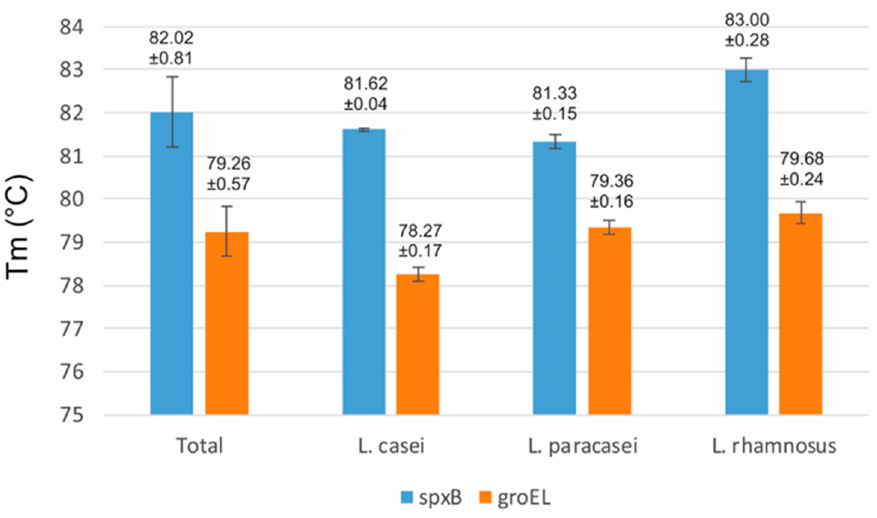
Figure 2. Average melting temperature of spxB and groEL amplicons obtained for 30 bacterial strains belong to L. casei , L. paracasei and L. rhamnosus species.